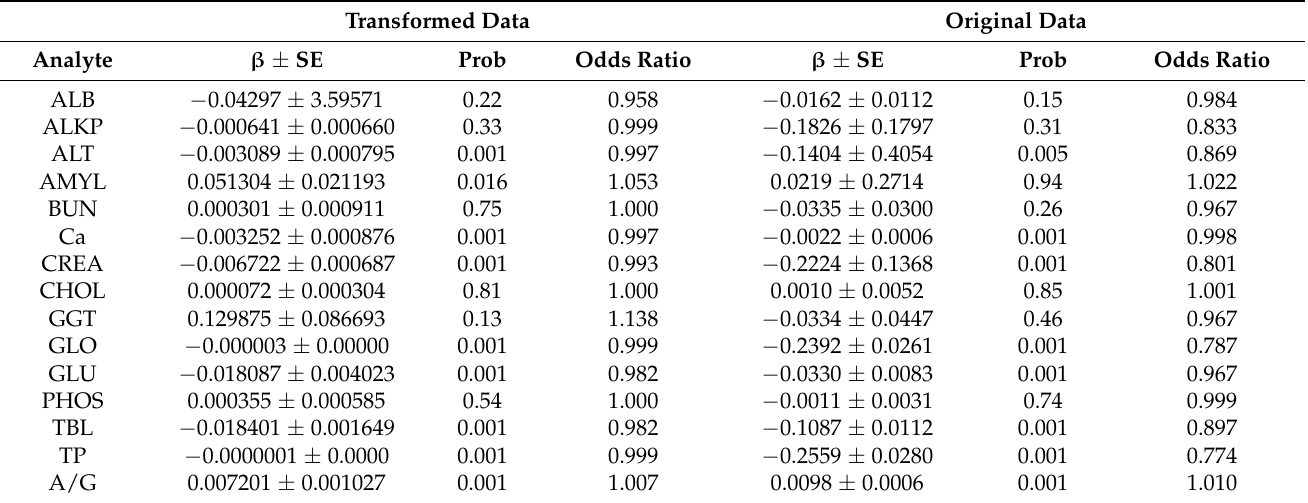
Table 8. Regression coefficients, standard errors, and odds ratios of the transformed and original data of serum analytes on the number of months